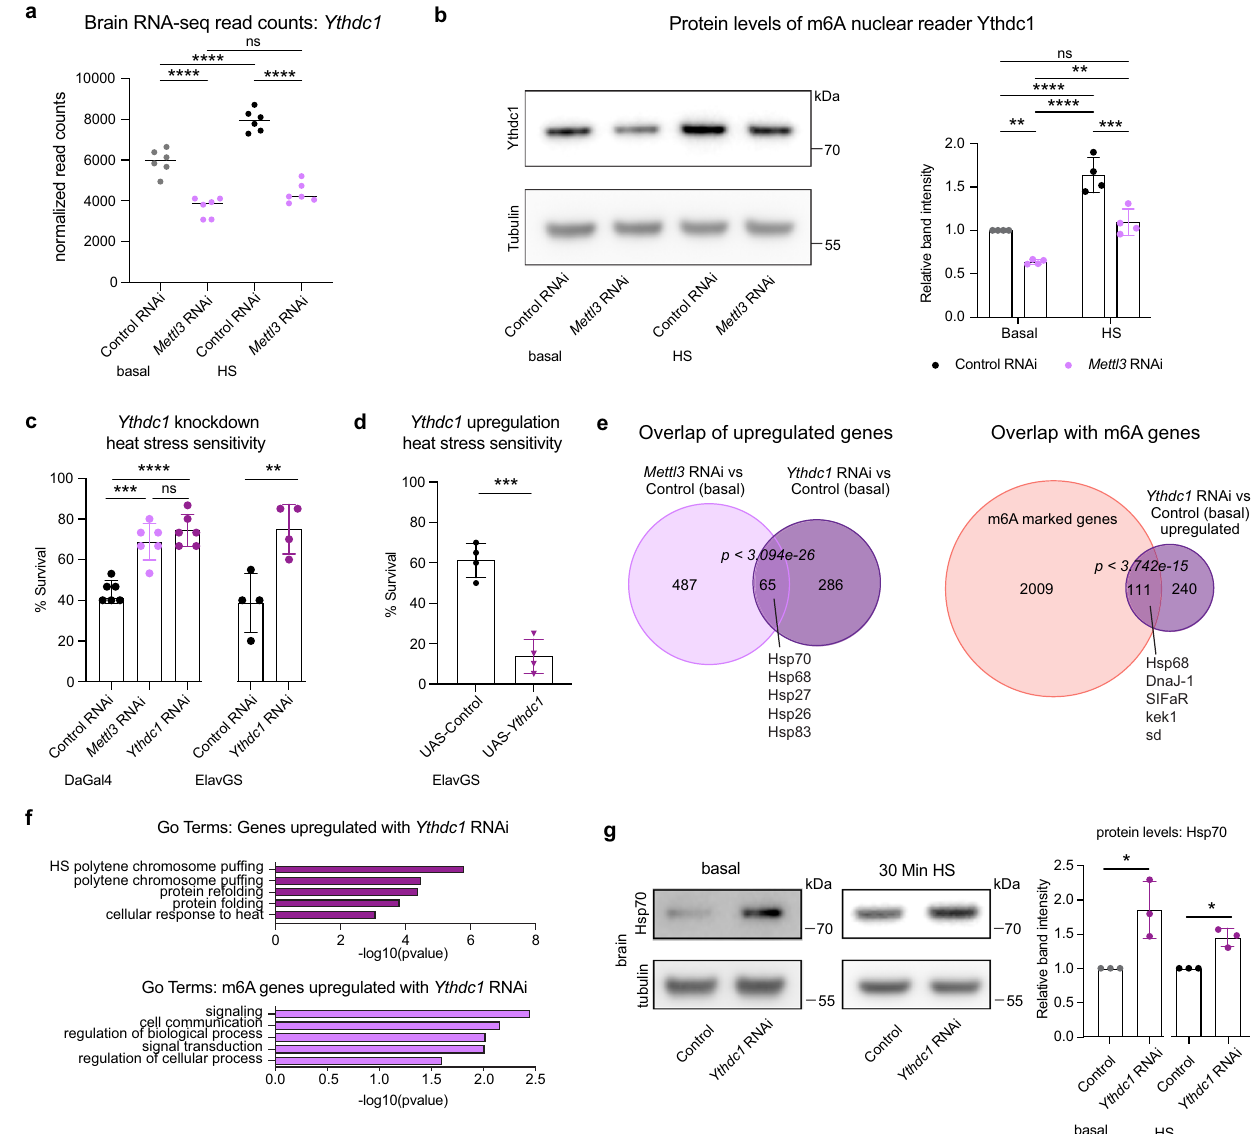
Fig. 7 | m 6 A reader protein Ythdc1 knockdown animals are resilient to heat stress. a Normalized read counts of Ythdc1 from brain RNA-sequencing in base- line, HS, Control, and Mettl3 RNAi conditions (Dagal4>mCherry RNAi vs Mettl3 RNAi).StatisticalanalysisfromRNA-seqdifferentialexpressionanalysis,provided in Supplementary Data 5. **** p <0.0001 From left to right p =1.53E-11, p =5.59E- 07, p =1.71E-38,nsnotsigni fi cant. b Ythdc1proteinlevelsfromDagal4>mCherry RNAi vs Mettl3 RNAi brains dissected in basal or HS 30min at 38.5°C. n =4, 15 brains per replicate. Quanti fi cation of four biological immunoblots show decreased expression of Ythdc1 protein in Mettl3 RNAi fl y brain and increase of Ythdc1 protein with HS. Data presented as mean±SD, ** p <0.01, *** p <0.001, **** p <0.0001. Student ’ s two-tailed t -test. p =0.0078, p <0.0001, p <0.0001, p =0.0013, p =0.0003. c Ubiquitousknockdownof Ythdc1orMettl3 (DaGal4),and neuron-speci fi c knockdown (ElavGS), and corresponding controls (mCherry RNAi)wereHSfor1.5hat38.5°Candscoredforsurvivalafter24hrecovery. n =6 biological replicates for DaGal4, n =4 biological replicates for ElavGS. Each data point representspercentsurvivalinavialof20 fl iesperreplicate.Datapresented as mean±SD, ** p <0.01, *** p <0.001, **** p <0.0001, One-way ANOVA, Student ’ s two-tailed t -test. p =0.0002, p <0.0001, ns not signi fi cant, p =0.0085. d Neuron-